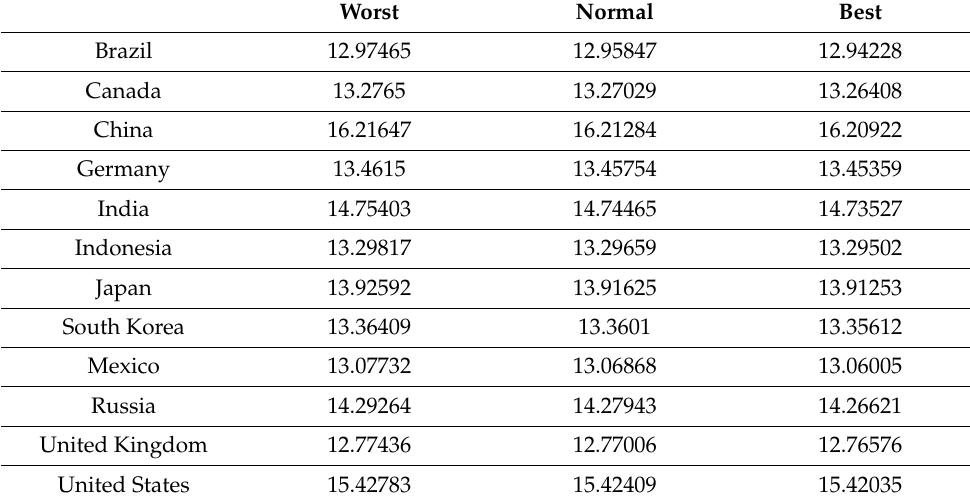
Table A3. Total CO 2 emissions in thousands of metric tons in three scenarios.